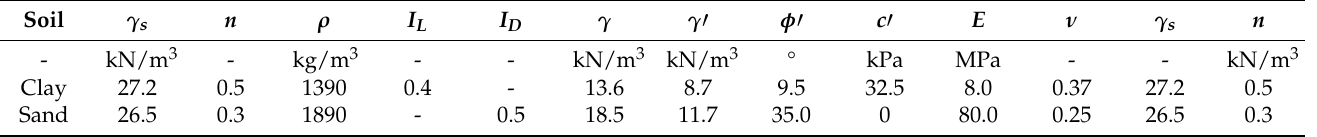
Table 1. Parameters of the media.